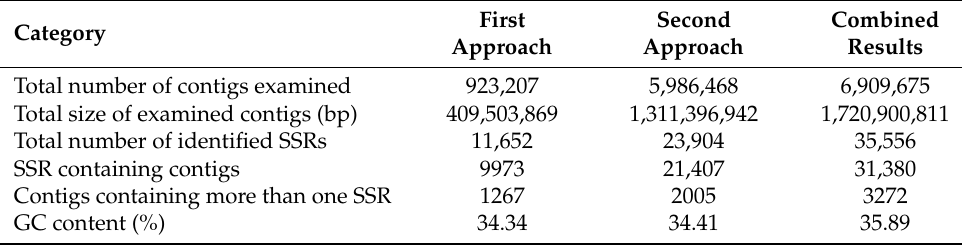
Table 1. Summary of de novo assembly and SSR